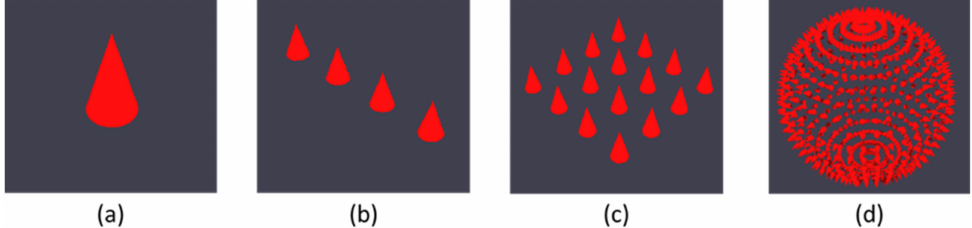
Figure 9. Different configurations of differential surfaces that can be specified through a single file, and therefore can be used in a single calculation. The shape in ( a ) illustrates a single differential surface. Shapes in ( b , c ) illustrate differential surfaces aligned along a line and distributed across an area respectively. The shape shown in ( d ) illustrates surface normals of planar surfaces that were created by subdividing a spherical surface.